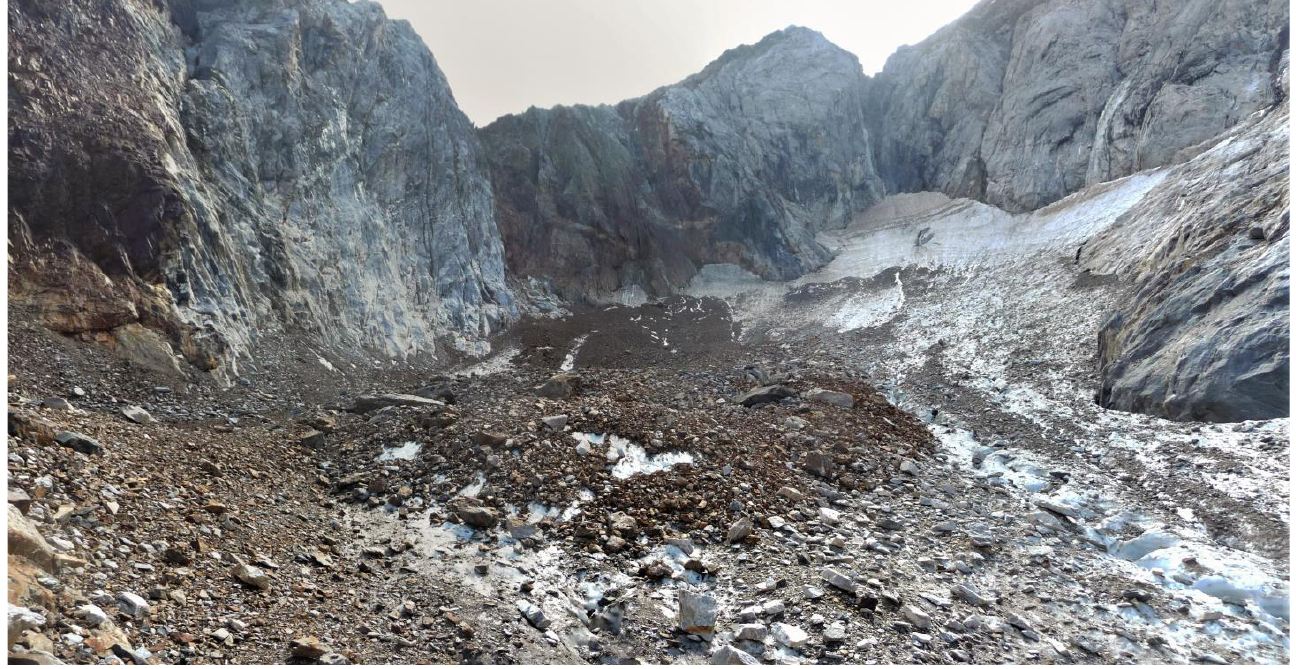
Figure 15. Mid-upper sector of the Infierno Glacier. August 30, 2022. Debris-covered glacier progress. Ice emerges. Table 3. Evolution of the Infierno Glacier, period 2016 – 2022. References over position in 2015 and over the previous year. Data in meters. Glacier front: longitudinal variation. Lateral glacier: thickness variation. Reference to surface prevalence of ice or firn.